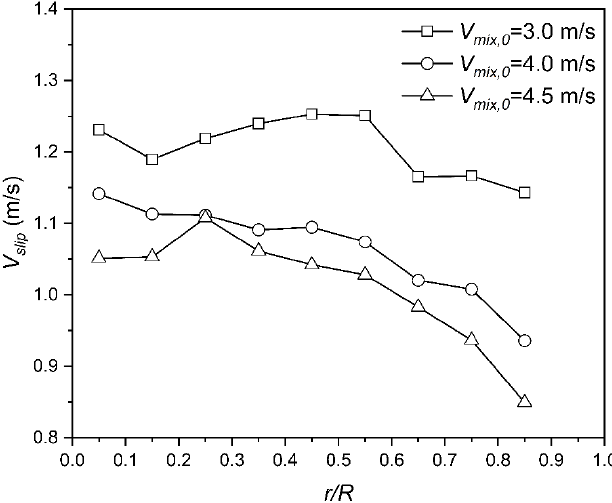
Figure 15. Effects of initial mixture velocity on average slip velocity ( C v ,0 = 5%, d s = 15.0 mm).